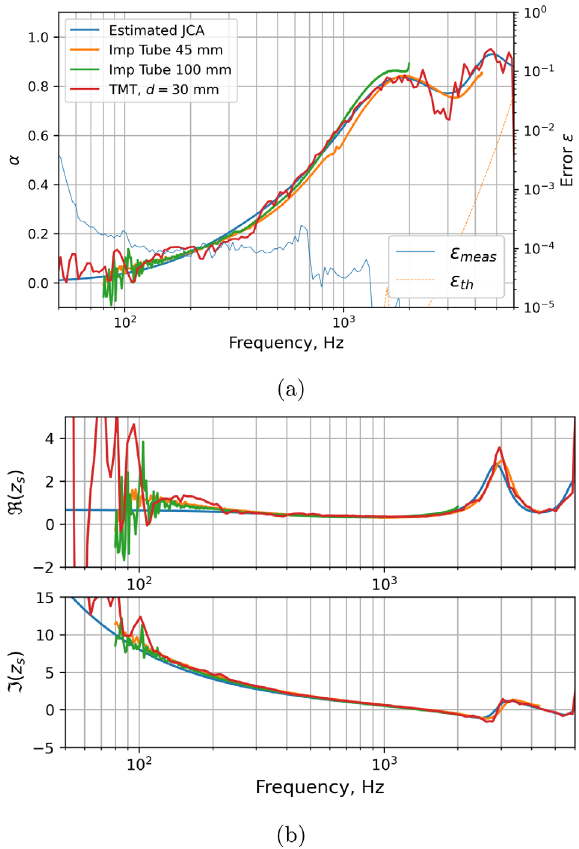
Figure 12. Absorption coef fi cient a and reproduction error (cid:2) (a), normalized surface impedance z s (b), for the con fi guration shown in Figure 2 at normal incidence with a = 105 cm, b = 20 cm, D m = 5 cm, h = 45 (cid:3) , / = 0 (cid:3) , k = 10 (cid:3) 7 , z a = 0.5 cm, d = 1.5 cm. (cid:2) th , (cid:2) meas : k = 10 (cid:3) 7 .